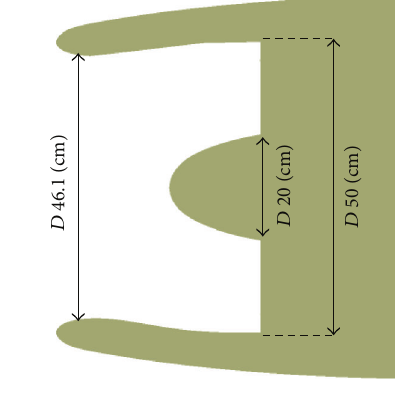
Figure 12: Intake geometry.